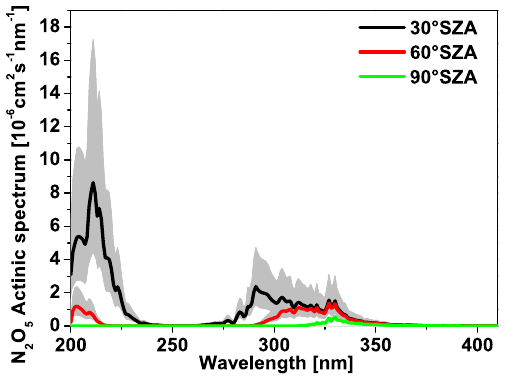
Figure 3. Actinic spectrum of N 2 O 5 (i.e. the product of (λ,T ) (at 230K) and modelled actinic fluxes) for an overhead σ N 2 O 5 ozone column of 283 Dobson units, and different SZAs at Fig. 3. Actinic spectrum of N 2 O 5 (i.e., the product of σ N 2 O 5 ( λ,T ) (at 230 K) and modelled actinic fluxes) for an overhead ozone column of 283 Dobson Units, and different SZAs at 30.5 km .